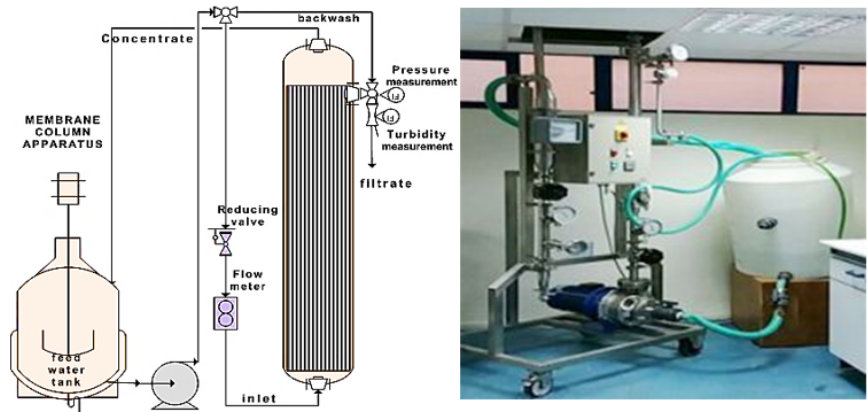
Figure 3. Ultrafiltration Membrane Unit.